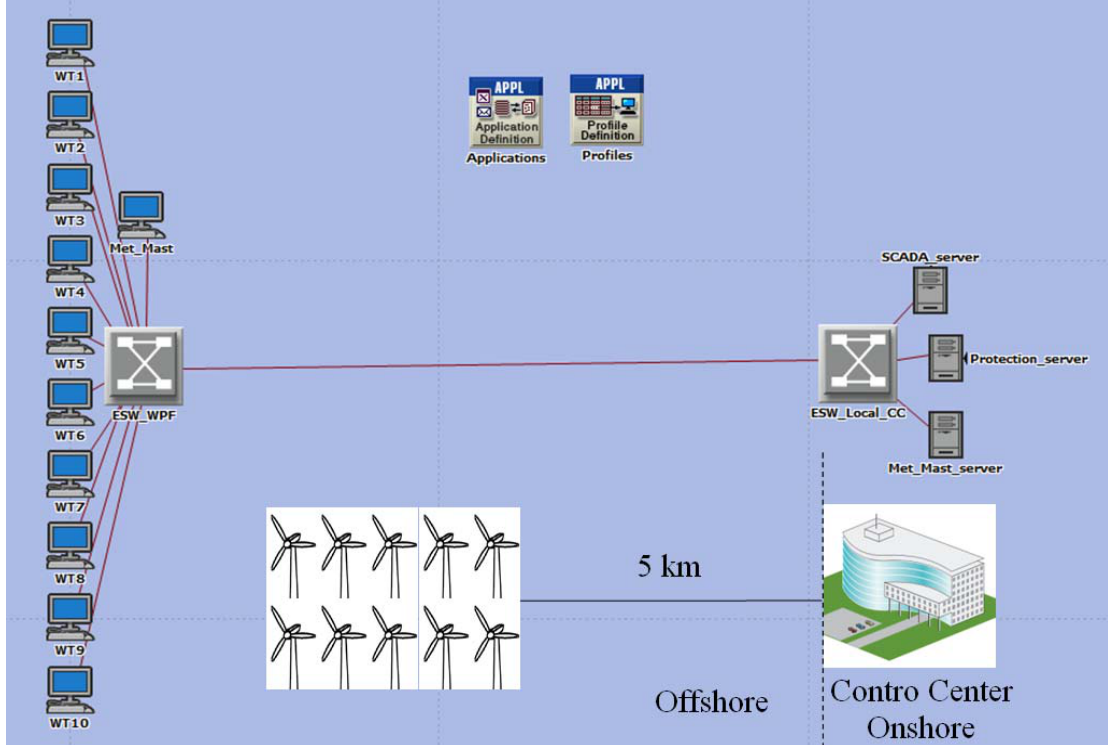
Figure 9. Network configuration of the small-scale WPF in